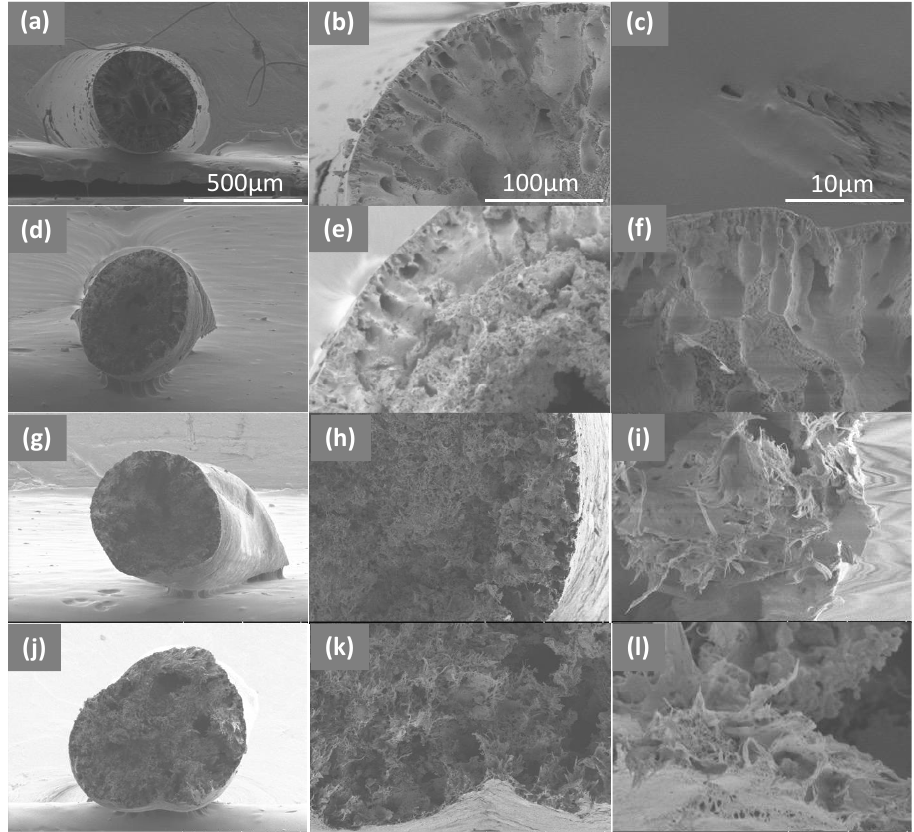
Figure 5. SEM images at different magnifications of the cross-sections of cryofractured samples of PET ( a – c ) and PET/graphene with loadings of 2 wt.% ( d – f ), 4 wt.% ( g – i ) and 5 wt.% ( j – l ). Scale bar in ( a – c ) applies to the images in the same column.